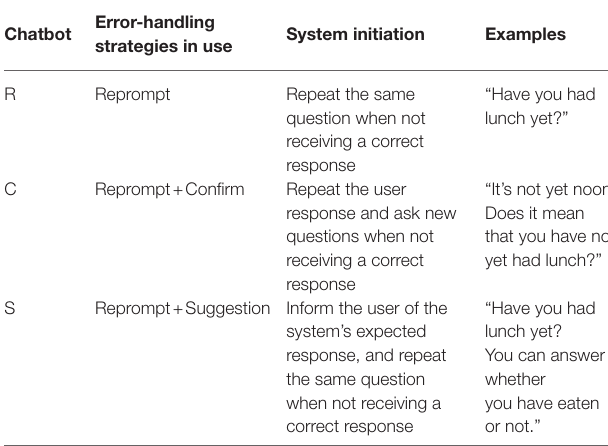
TABLE 1 | Design of the experimental